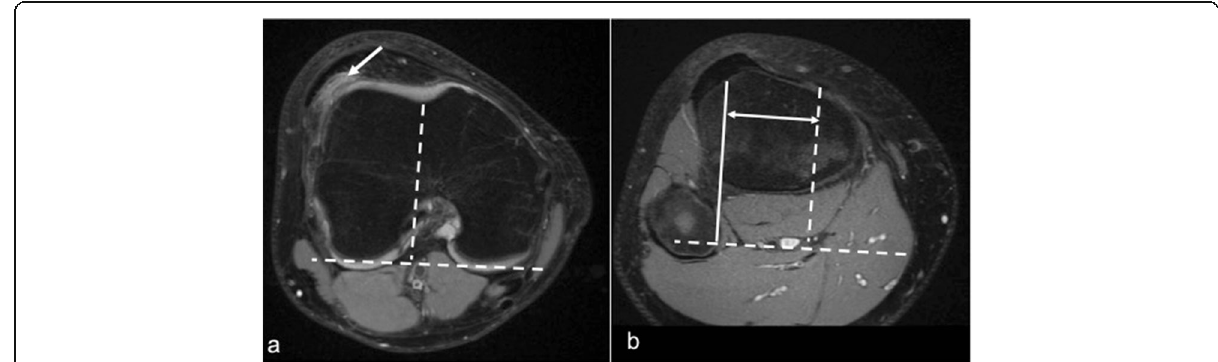
Fig. 5 Tibial tubercle – trochlear groove distance (TT-TG) assessment. a Axial PDFS right knee MR image at the level of the trochlear groove. b Axial MRI at the level of the tibial tuberosity. TTTG is the distance between the solid and the dashed lines in ( b ). Note the edema in the superolateral aspect of Hoffa ’ s fat pad